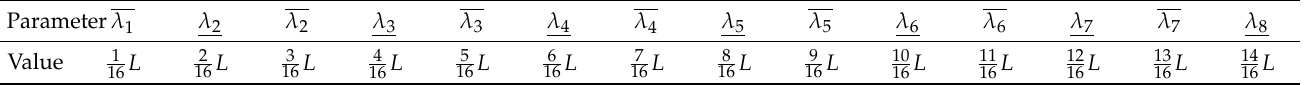
Table 3. The values of parameters.